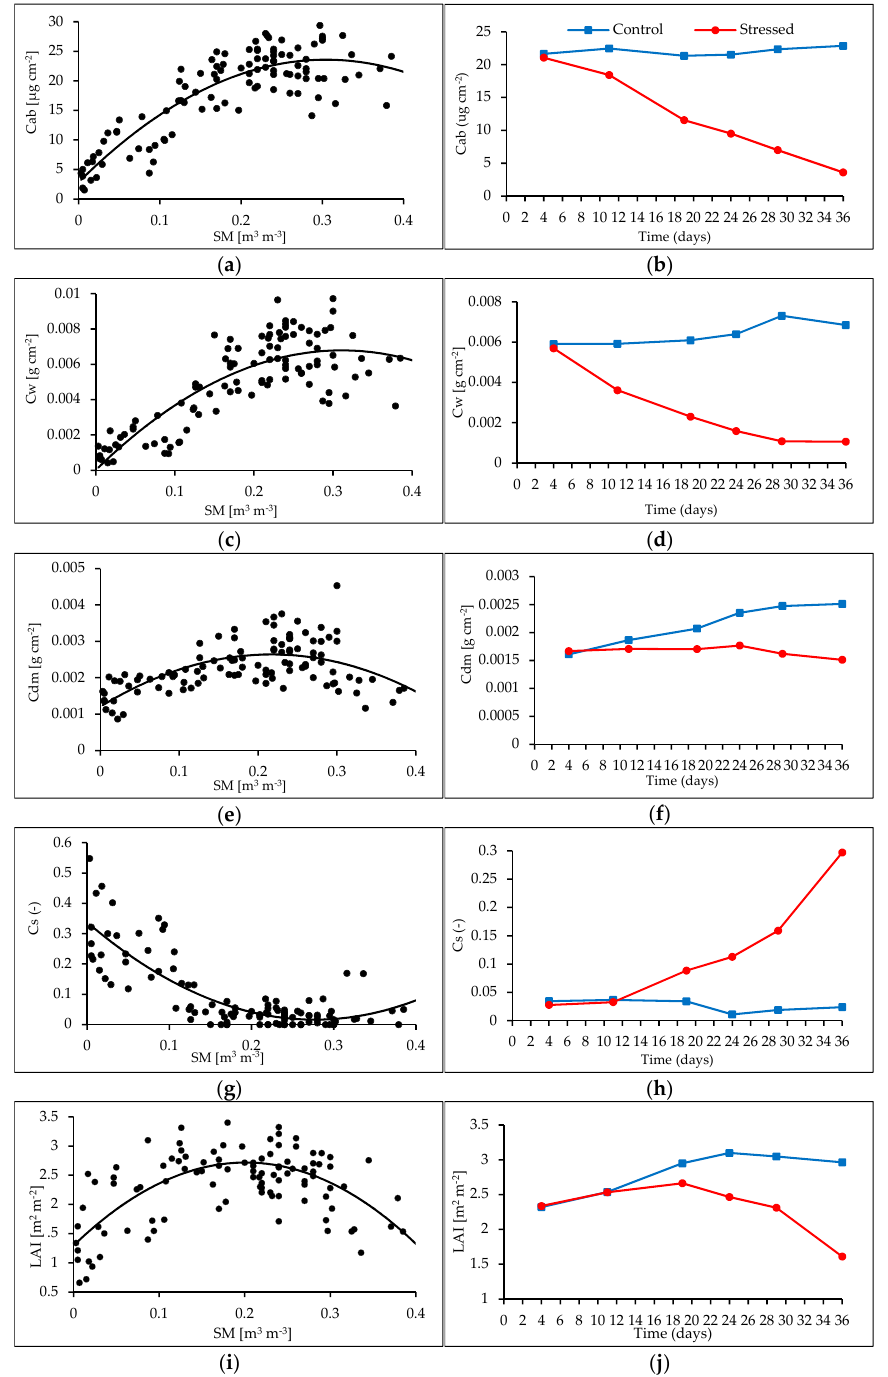
Figure 11. ( a – j ) Trend of the retrieved parameters. Left panels show parameter changes with soil moisture deficit and the right panels show the changes over time. ( a ) Chl and soil moisture deficit; ( c ) Cw and soil moisture deficit; ( e ) Cdm and soil moisture deficit; ( g ) Cs and soil moisture deficit; ( i ) LAI and soil moisture deficit; ( b ) Chl changes over time; ( d ) Cw changes over time; ( f ) Cdm changes over time; ( h ) Cs changes over time; ( j ) LAI changes over